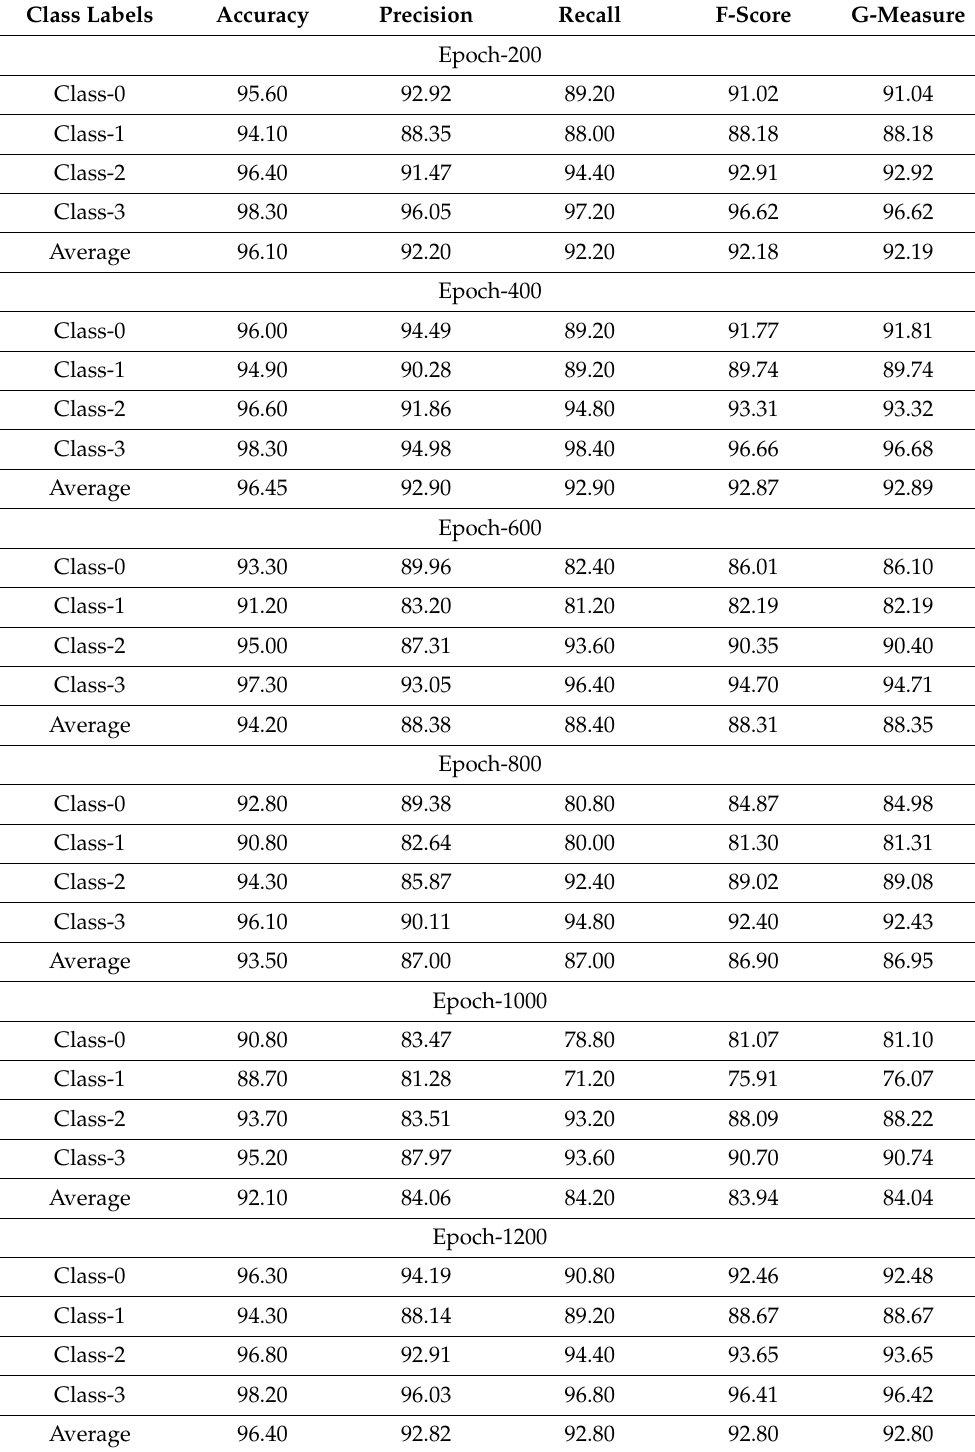
Table 2. Result analysis of MDTL-ICDDC technique with distinct measures and